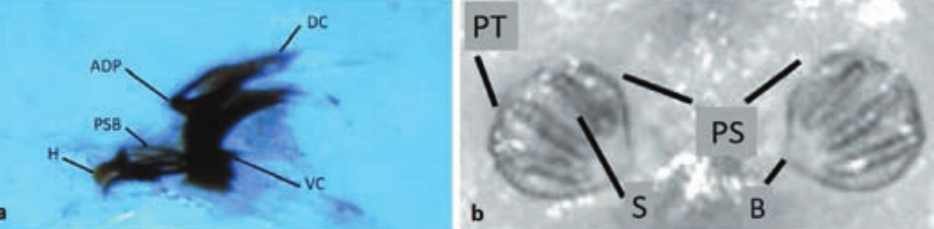
Fig.1. Different larval instars of H. ligurriens ( a) First Instar (b) Second Instar (c) Third Instar